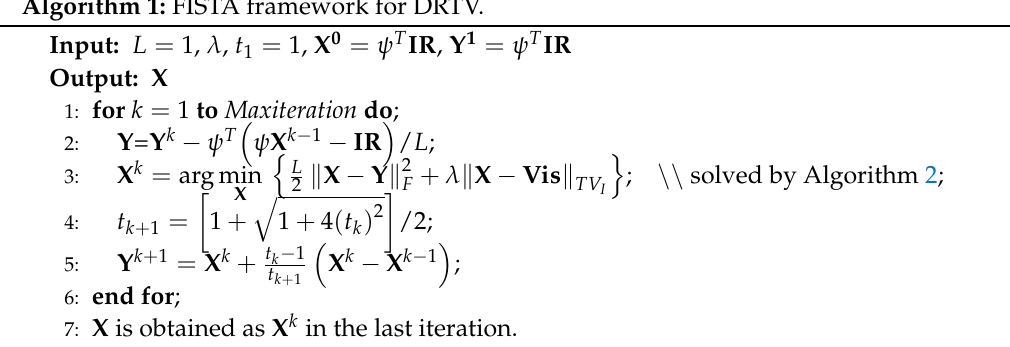
Algorithm 1: FISTA framework for